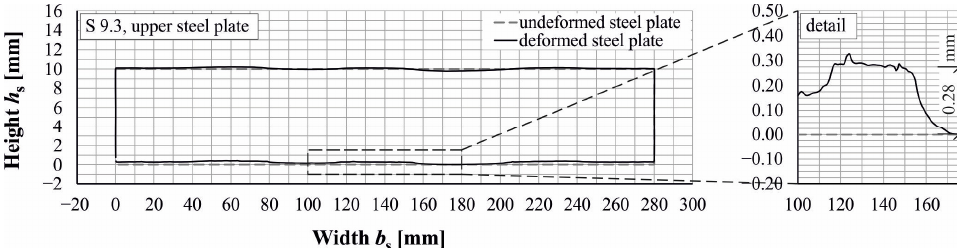
Figure 8. Deformations of the lower steel plate of S 9.2.